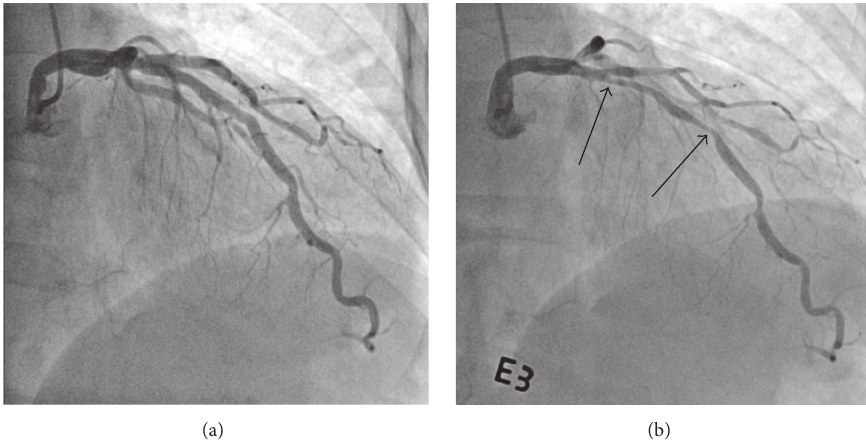
Figure 1: (a) Coronary angiography showed atherosclerotic change with mild stenosis in the left anterior descending artery. (b) Ergonovine provocation induced coronary spasm in the mid-left anterior descending artery (arrows), causing up to 70% stenosis as demonstrated by quantitative coronary analysis.